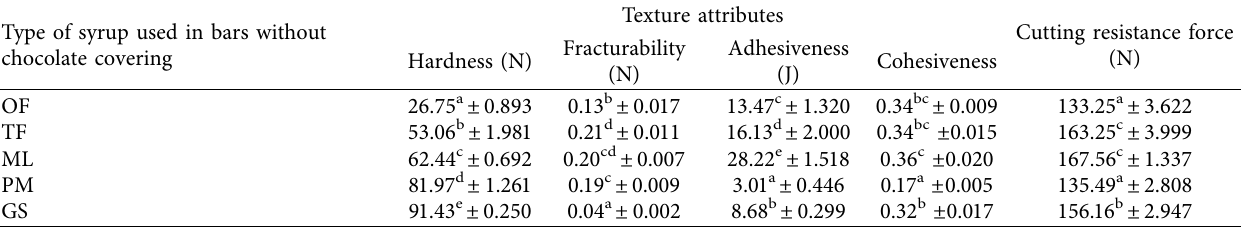
Table 1: Impact of different syrup applications on high-protein bars texture attributes and cutting resistance.